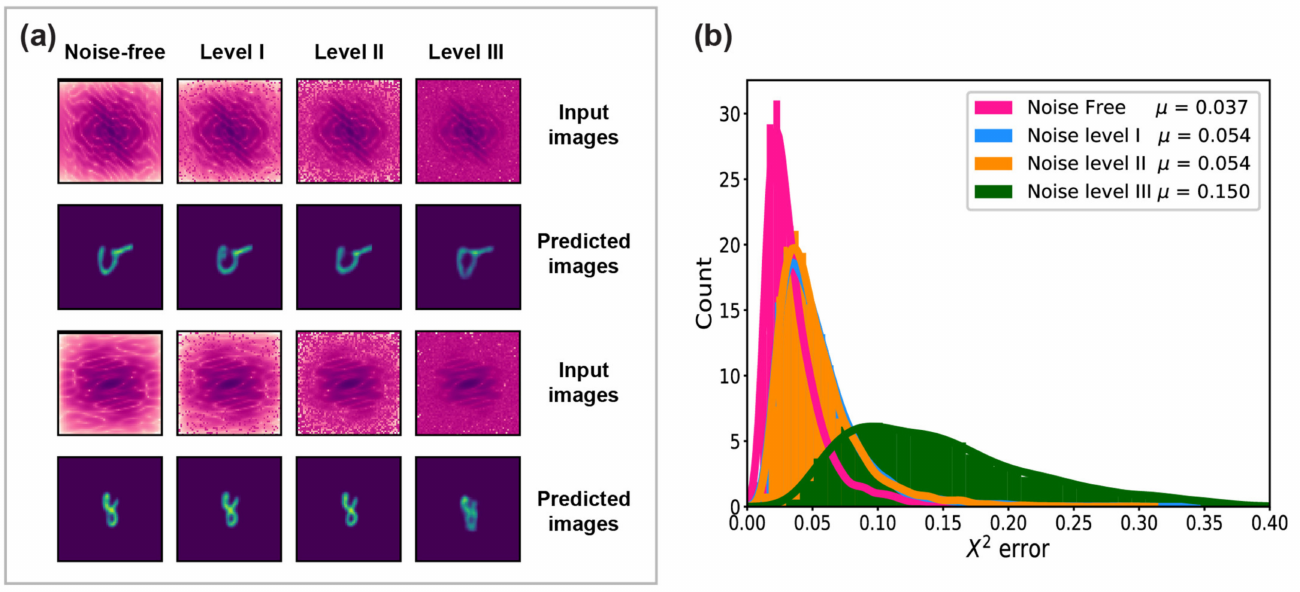
Figure 7. The deep neural network model is trained with the level II noisy diffraction images. ( a ) The first and third row are input images, and the second and fourth row are the corresponding predicted images. ( b ) The histograms of X 2 errors show the performances of four